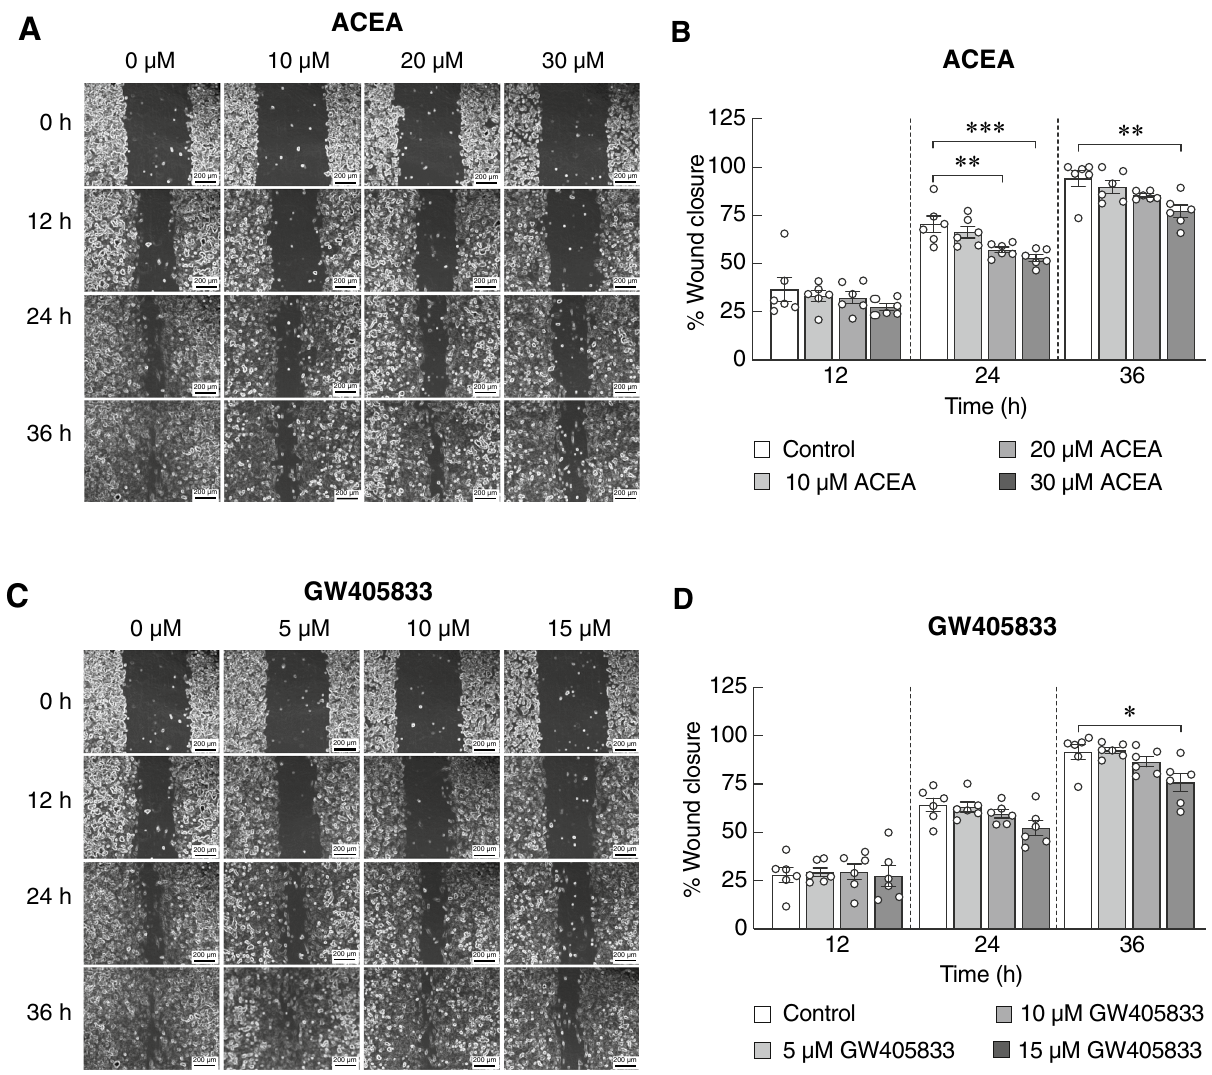
Figure 7. Inhibitory effects of ( a , b ) ACEA and ( c , d ) GW405833 on MDA-MB-231 cell migration ( a and c ) Representative images illustrated MDA-MB-231 cell migration after being treated for 12, 24 and 36 h with the indicated concentrations of the compounds. ( b and d ) Percent wound closure representing cell migration was assessed by wound healing assay. Each column represents mean ± SEM of three independent biological replicates with two technical duplicates each. (*** p < 0.001, ** p < 0.01, * p <